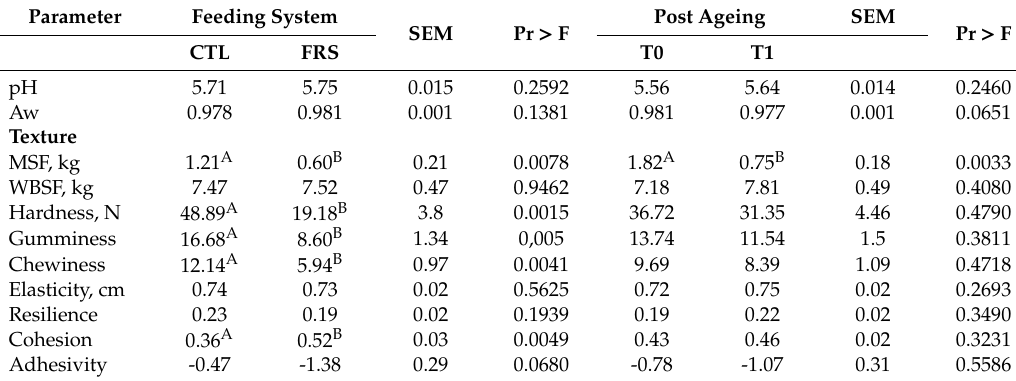
Table 4. E ff ect of feeding system and post dry ageing on meat quality of bu ff aloes fed with (FRS; n = 8) or without (CTL; n = 8) ray grass in Semitendinosus